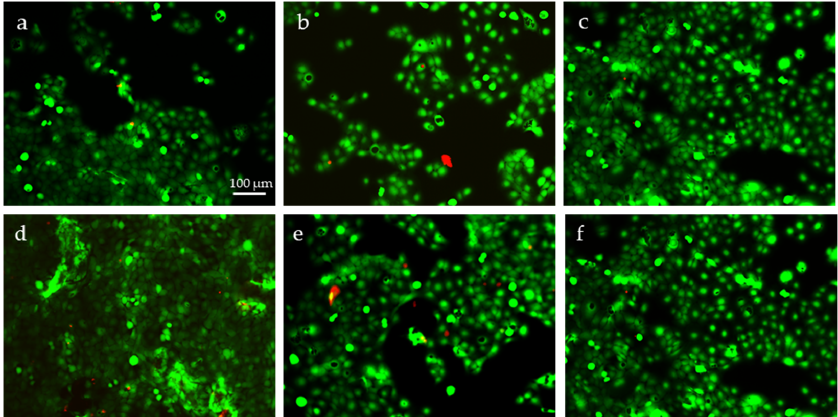
Figure 6. Indirect cytotoxicity test: Live/Dead viability test performed on HaCaT cell line cultured in DMEM previously incubated with cellulose tissues electrosprayed with: ( a ) sCNs (water); ( b ) sCNs (water/acetic acid); ( c ) sCNs (water/HFlP); ( d ) mCNs (water); ( e ) mCNs (water/acetic acid). ( f ) Pristine cellulose tissue. Viable cells are stained in green; dead cells are stained in